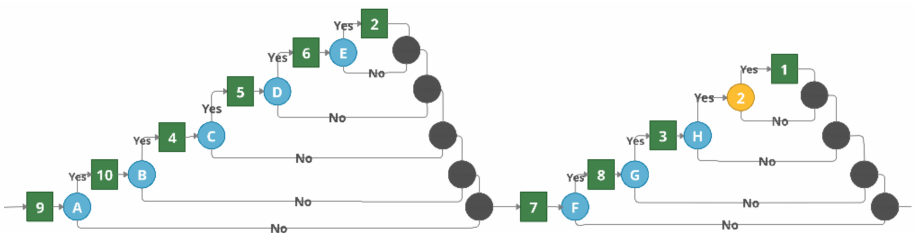
Figure 10. Result of BTCG transformation for competence tree, presented in Figure 8, when all competencies except 2nd level competencies 2 and 3 are sequentially